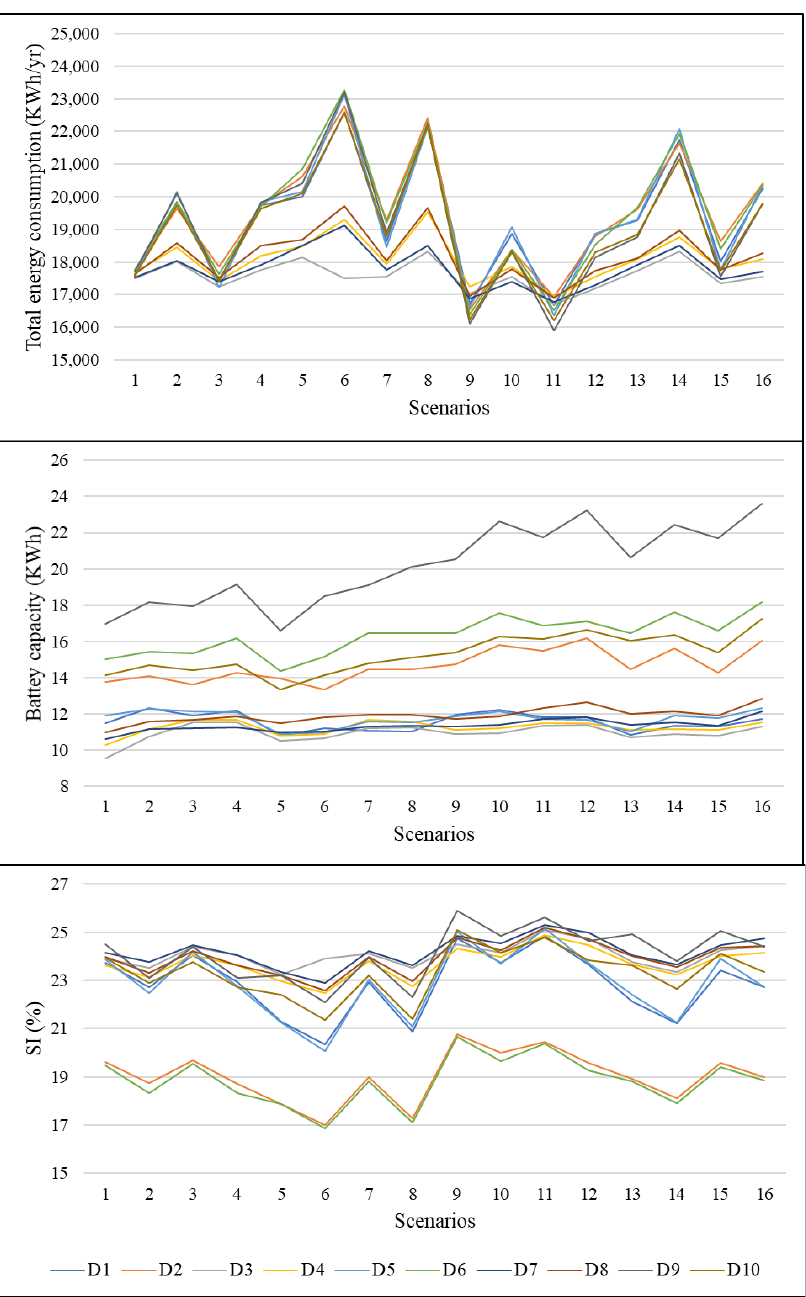
Figure A1. The impacts of the 16 uncertainty scenarios on total energy consumption, cost-effective battery capacities, and the savings indexes of the ten designs for the measured power rate